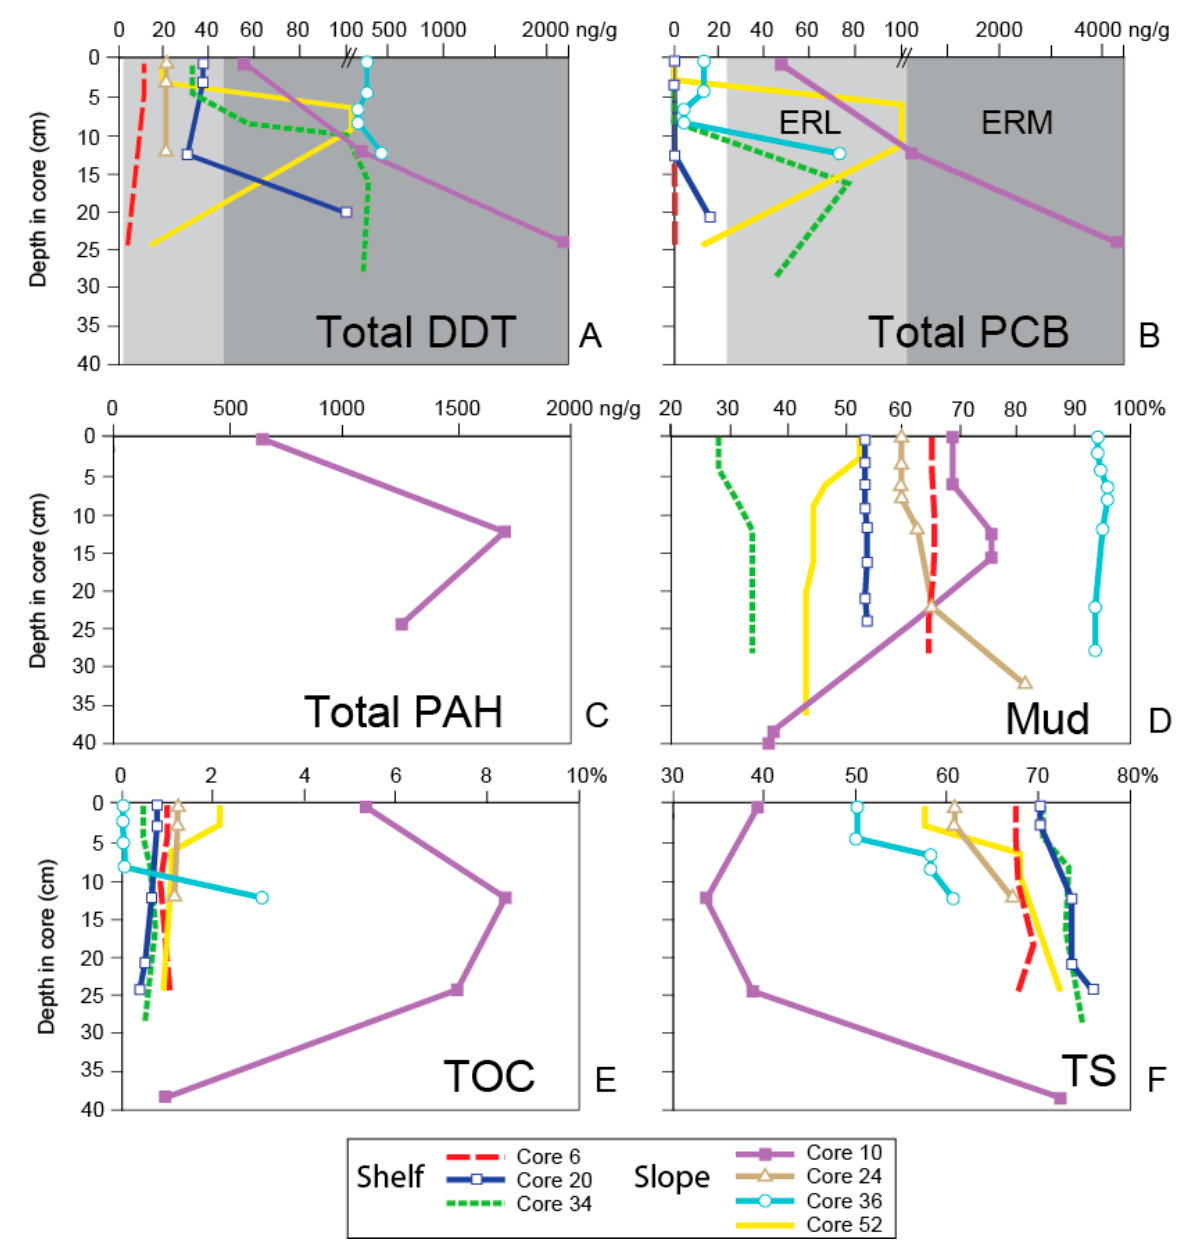
Figure 6. Relative abundance (in ng/g) of trace organics and sediment constituents (in percent) with depth in seven cores. Cores 6, 20, and 34 were obtained on the shelf and cores 10, 24, 36, and 52 were obtained on the slope. ( A ) total DDT = total dichlorodiphenyltrichloroethane, ( B ) total PCB = total polychlorinated biphenyls, ( C ) total PAH = total polycyclic aromatic hydrocarbons, ( D ) percent mud fraction, ( E ) percent total organic carbon (TOC), and ( F ) percent total solids (TS). ( A ) and ( B ) only: effects range-low (ERL) values (light shading) and effects range-median (ERM) values (darker shading) as defined by Long et al. [76]. Note change in horizontal scale in ( A , B ).